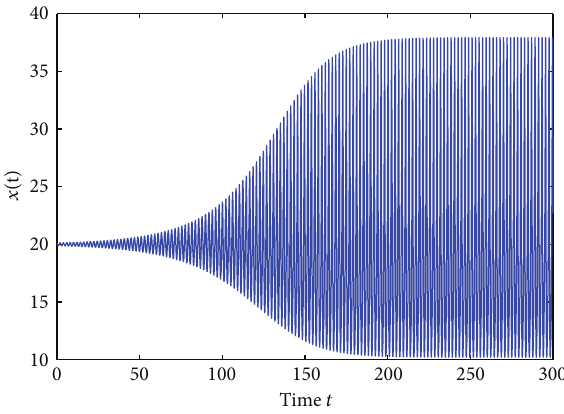
Figure 4: Waveform plot of 𝑡 - 𝑥(𝑡) with 𝜏 = 0.206 .